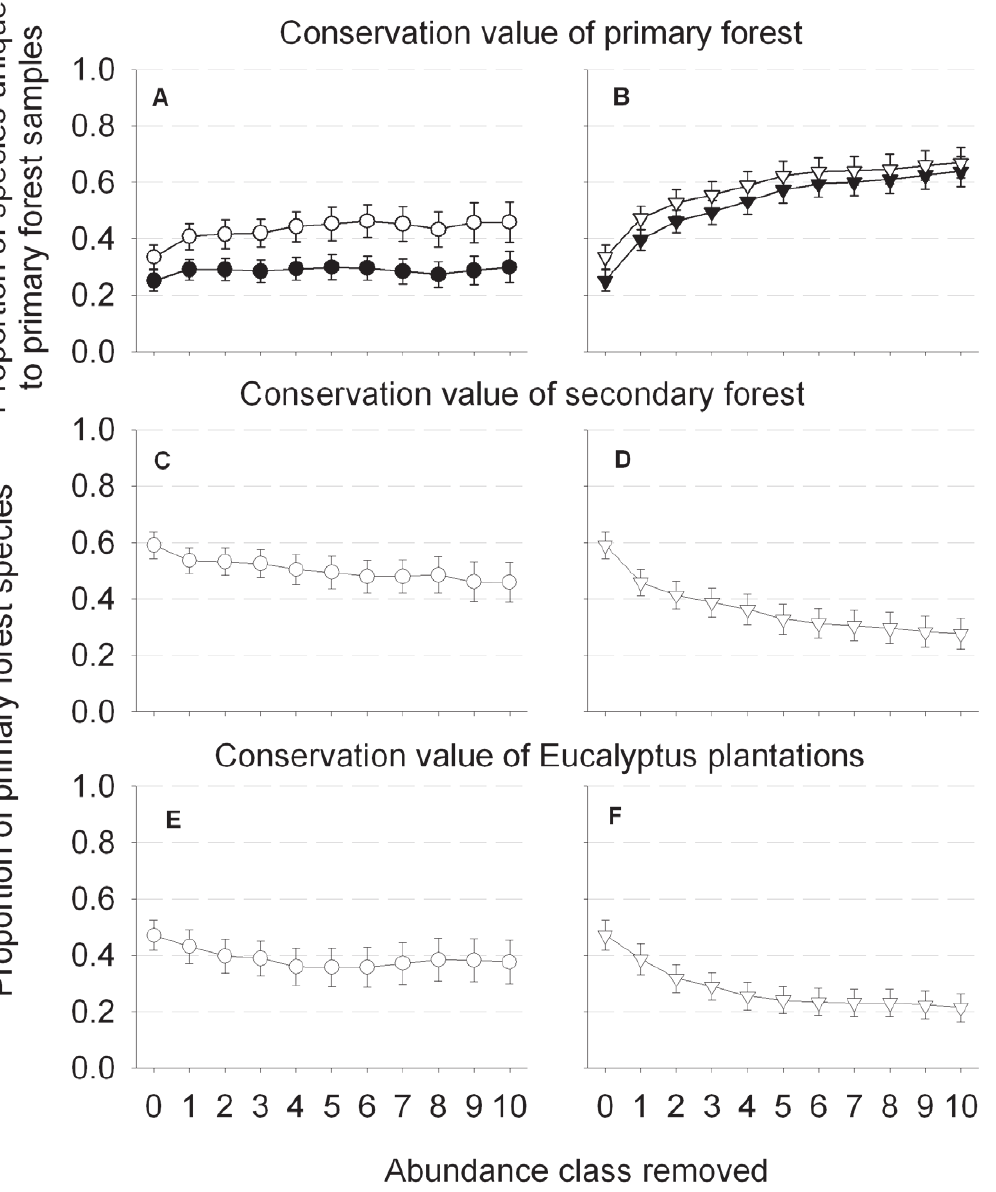
Figure 1. The conservation value of forests in the Jari landscape. Panels show how the metric of conservation value changes in primary forest (a & b), secondary forest (c & d) and Eucalyptus plantations (e & f) as an increasing number of abundance classes of occasional species are sequentially removed from the analysis. Values represent the mean proportion ( 6 SE) from 15 vertebrate, invertebrate and plant taxa sampled. Panels on the left (a, c & e) represent values when occasional species are removed from all forest types simultaneously (symbols as circles), while panels on the right (b, d, & f) represent values when occasional species are only removed from modified forest types (symbols as triangles). Solid and open symbols (panels a & b) represent the proportion of the entire species pool, and the proportion of primary forest species (i.e. only species that were recorded at least once in primary forest), respectively.